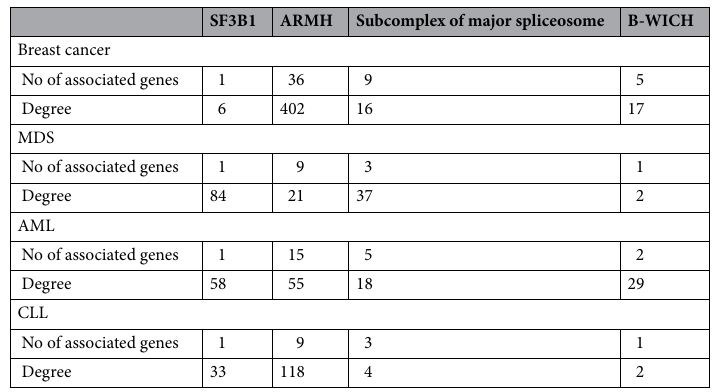
Table 5. The association between each of the four diseases and SF3B1 or its family separately based on DisGeNET and degree